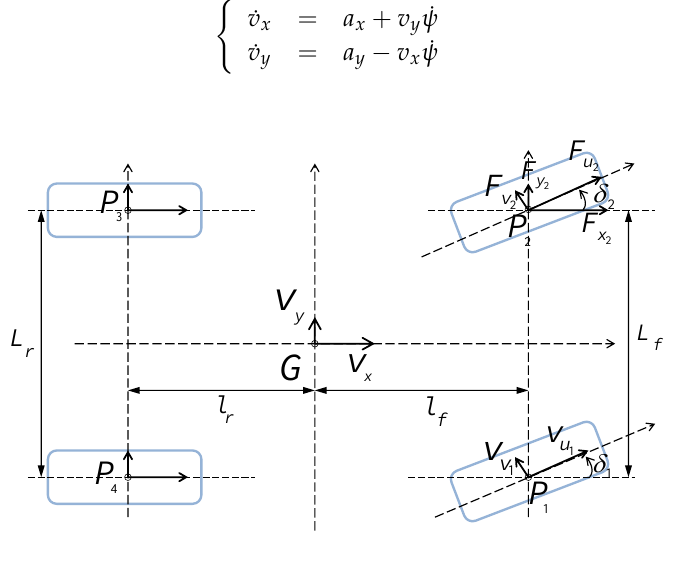
Figure 2. The two-track